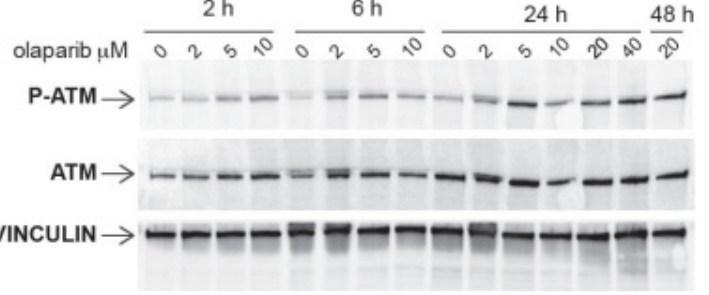
Figure 5. Expression ( ATM ) and phosphorylation (P- ATM ) of the ATM protein in the MET overex- pressing EBC-1 cells' response to the treatments with the indicated concentrations of olaparib after the indicated times. Vinculin was used as loading control.